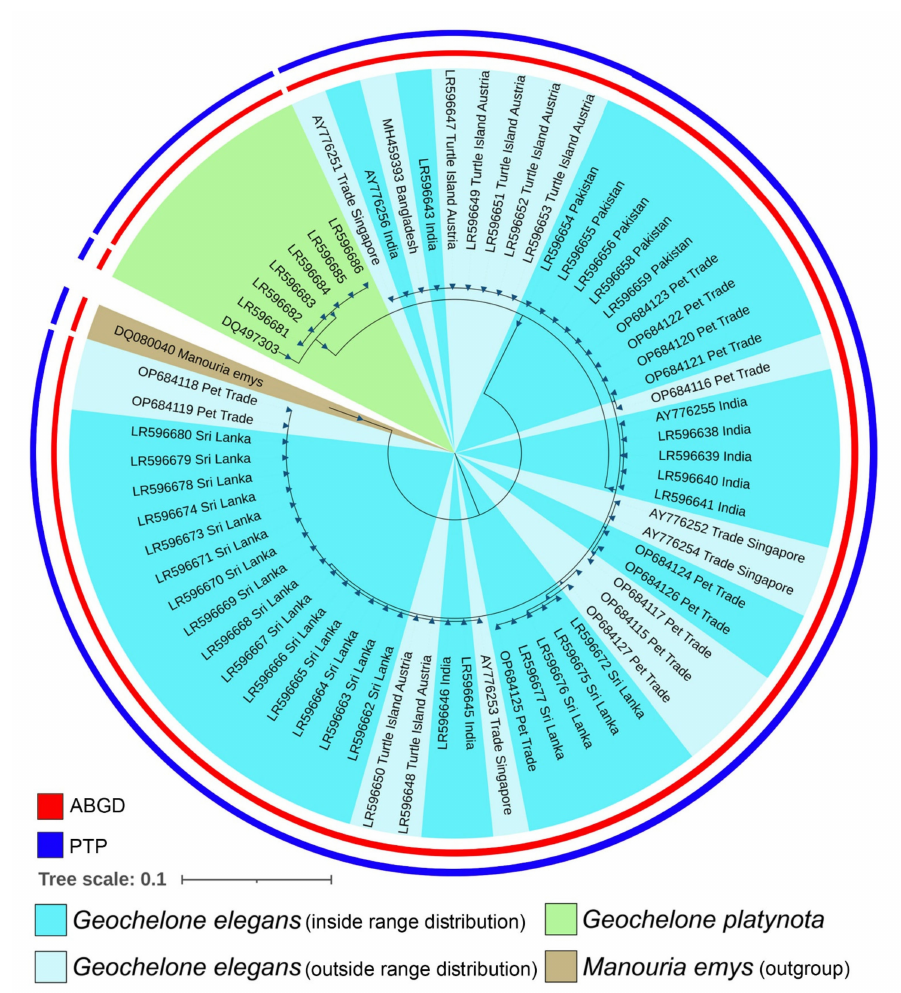
Figure 3. Unified Bayesian (BA) phylogenetic tree, based on the mitochondrial Cytb gene, shows the clustering pattern of G. elegans and G. platynota . The BA posterior probability support of each node was superimposed and marked by differently sized blue triangles. NCBI accession numbers and collection information are represented, with each node in parentheses. The red- and blue-colored bars indicate delineated MOTUs by ABGD and PTP,